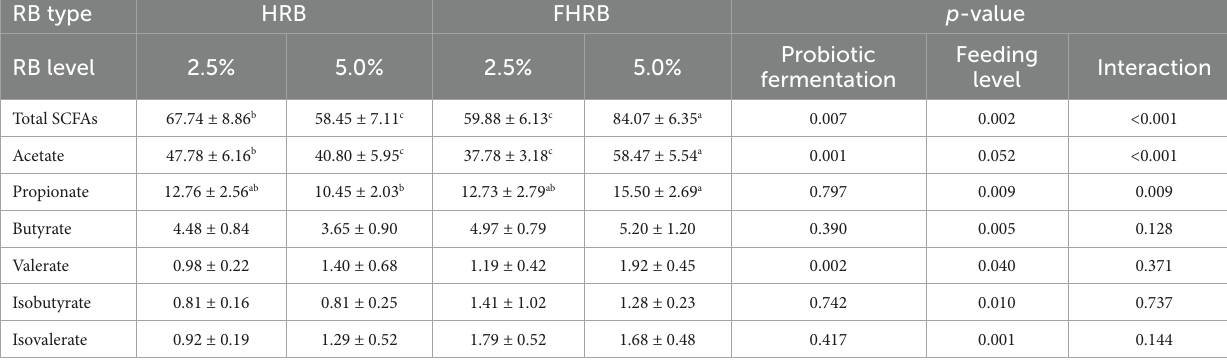
TABLE 4 Effects of RB type and feeding level on short-chain fatty acids in cecal chyme of laying hens.